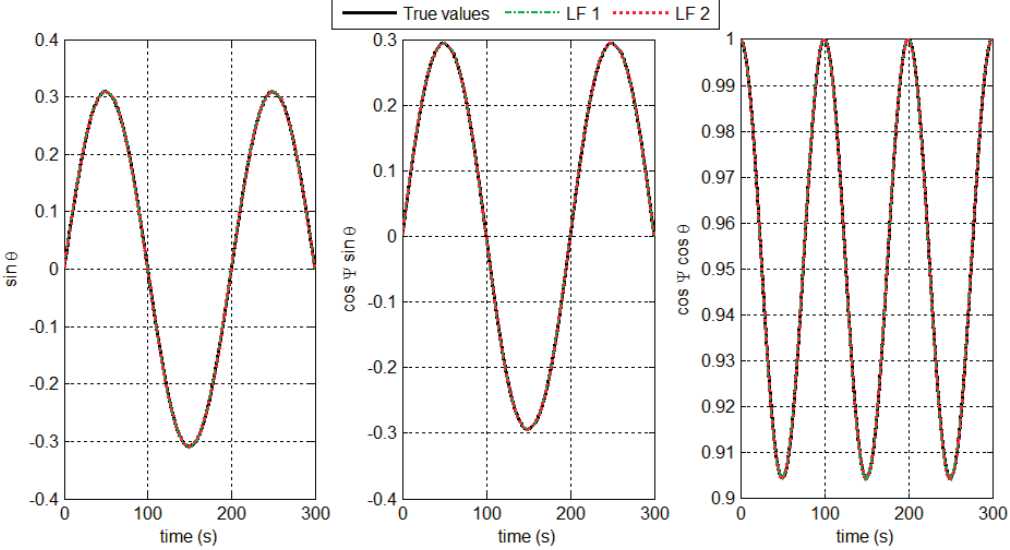
Figure 9. Attitude estimates in the target positioning system.